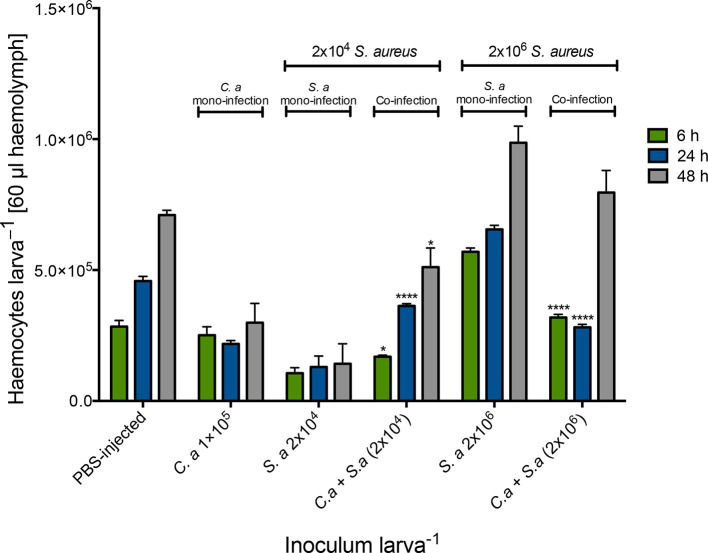
Alteration in circulating haemocyte density following inoculation with 
S. aureus
 cells alone and in combination with C. albicans. G. mellonella larvae were inoculated with 20 µl S. 
aureus
 cells (2×104 and 2×106 larva−1) alone or in combination with C. albicans (1×105 larva−1) and haemocytes were extracted and enumerated from 6, 24 and 48 h post-inoculation at 37 °C. Statistical analysis was performed by comparing co-infected larvae (C. a+S.a) to 
S. aureus
-only-treated larvae at their at respective doses and time points (*, P<0.05; **, P<0.01; ***, P<0.001; ****, P<0.0001). All values are the mean±se of three independent experiments.